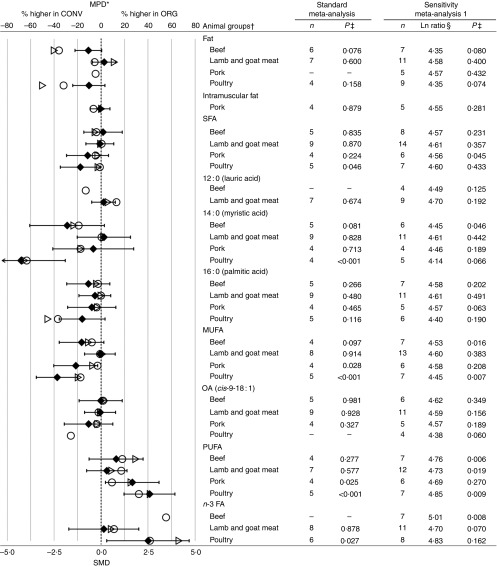
Results of the standard weighted meta-analysis and sensitivity analysis 1 for
different animal groups for fat composition in meat. * Numerical values for mean
percentage difference (MPD) and 95 % CI are given in the online Supplementary Table
S10. † For parameters for which n≤3 for specific animal group,
results obtained in the meta-analyses are not shown. ‡ Ln ratio=ln (ORG/CONV×100 %).
§ P value <0·05 indicates a significant difference between
organic samples (ORG) and conventional samples (CONV). n, number of
data points included in the meta-analyses; OA, oleic acid; FA, fatty acids; SMD,
standardised mean difference; ○, MPD calculated using data included in standard
unweighted meta-analyses; ▷, MPD calculated using data include in standard weighted
meta-analysis; ◆, SMD with 95 % CI represented by horizontal bars.